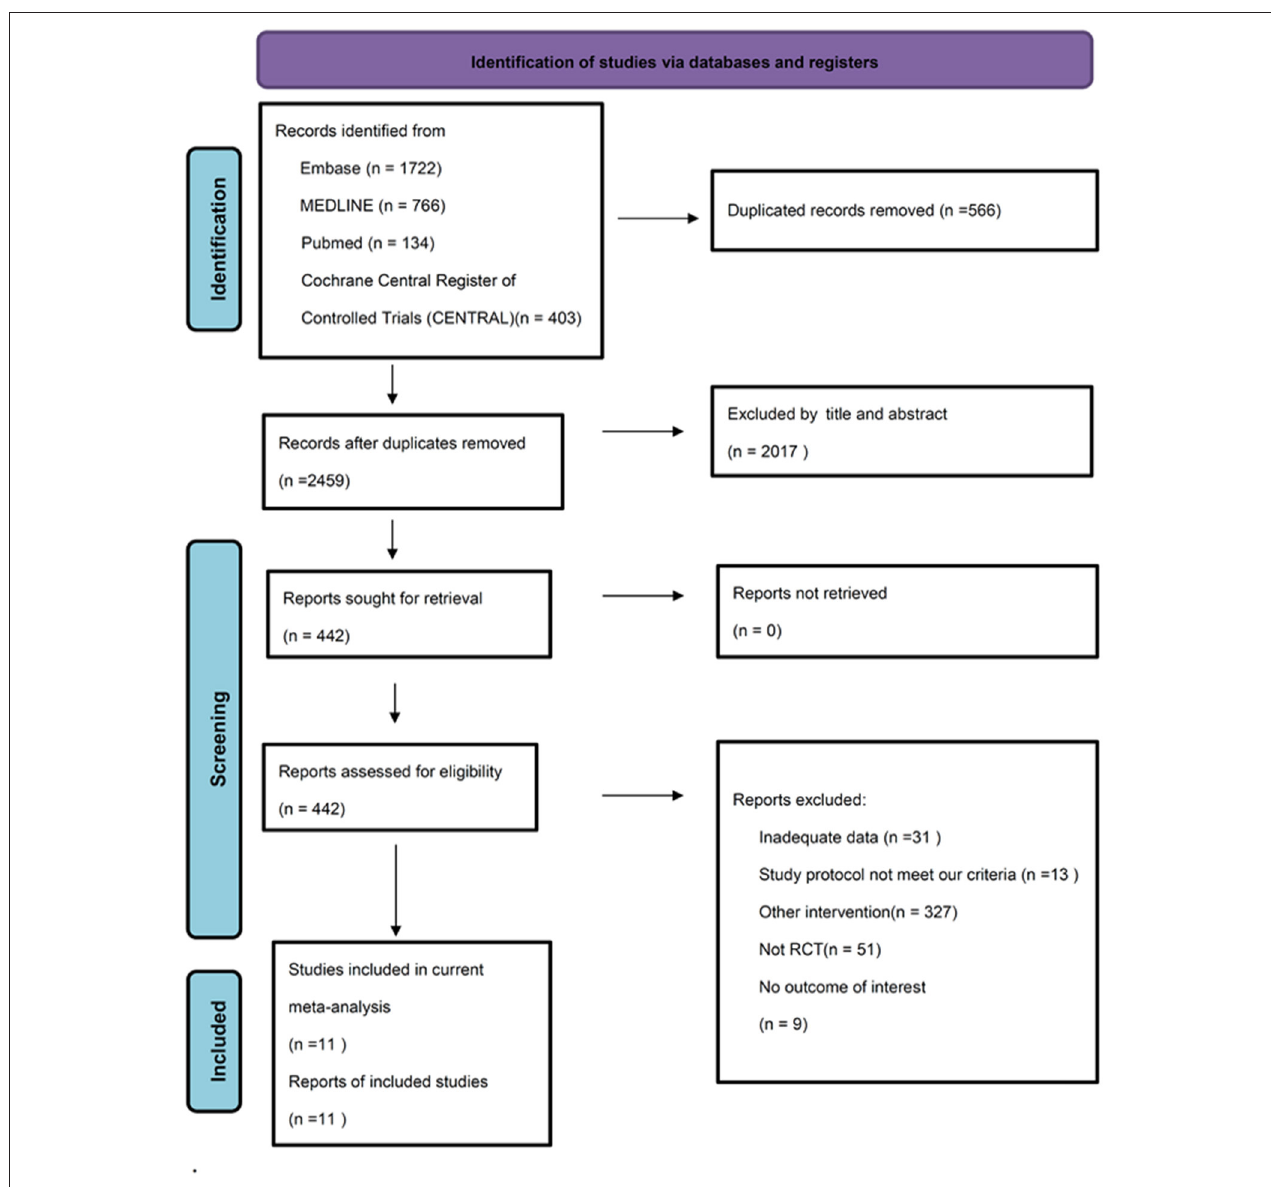
FIGURE 1 | PRISMA flowchart of study